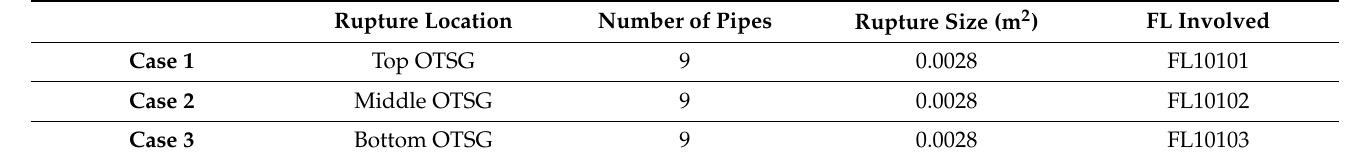
Table 14. Summary of simulation